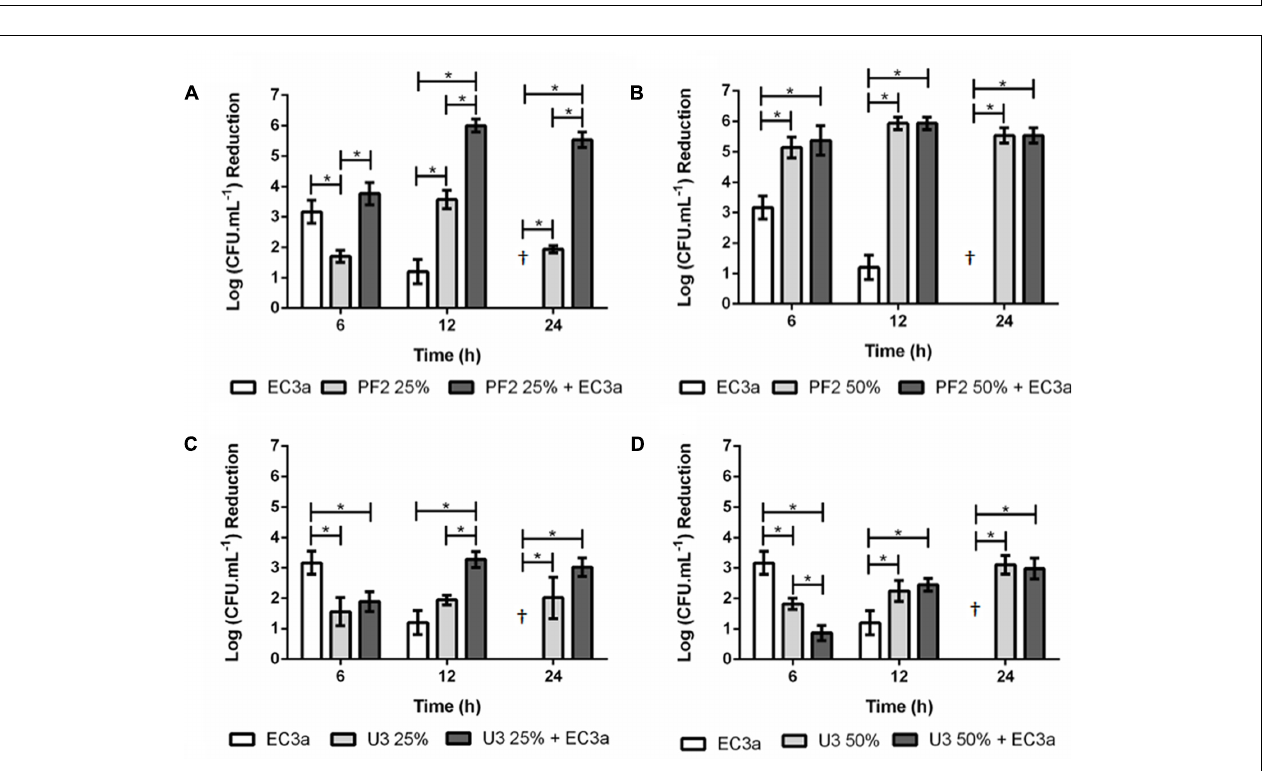
FIGURE 3 | Antibiofilm effect of phage EC3a, honey, and of the phage–honey combination on 24-h-old E. coli biofilms. (A) PF2 25% , (B) PF2 50% , (C) U3 25% , (D) U3 50% . † Values present no reductions compared to control samples. ∗ Indicates that the difference is statistically significant at the p -value < 0.05